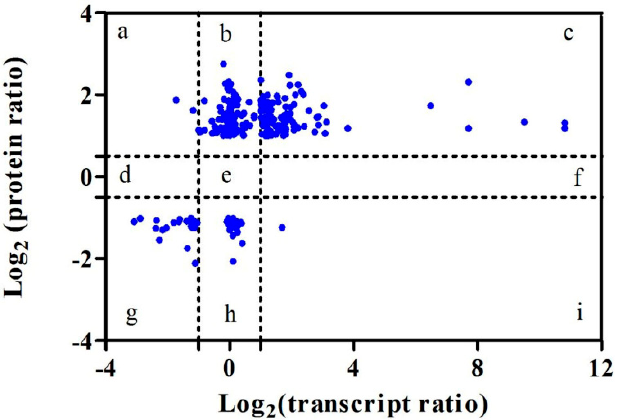
Figure 5. Comparisons of changes in mRNA levels and protein abundance. The relative changes are shown on a log 2 scale (transcript/protein ratio) on the x- and y-axes, respectively. Quadrant a: the DEGs were down-regulated ≥ 2-fold and the DAPs were up-regulated ≥ 1.5-fold. Quadrant b: DEGs were up-/down-regulated ≤ 2-fold, and DAPs were up-regulated ≥ 1.5-fold. Quadrant c: DEGs were up-regulated ≥ 2-fold and DAPs were up-regulated ≥ 1.5-fold. Quadrant g: DEGs were down-regulated ≥ 2-fold and DAPs were down-regulated ≥ 1.5-fold. Quadrant h: DEGs were up-/down-regulated ≤ 2-fold and DAPs were down-regulated ≥ 1.5-fold. Quadrant i: DEGs were up-regulated ≥ 2-fold and DAPs were down-regulated ≥ 1.5-fold.